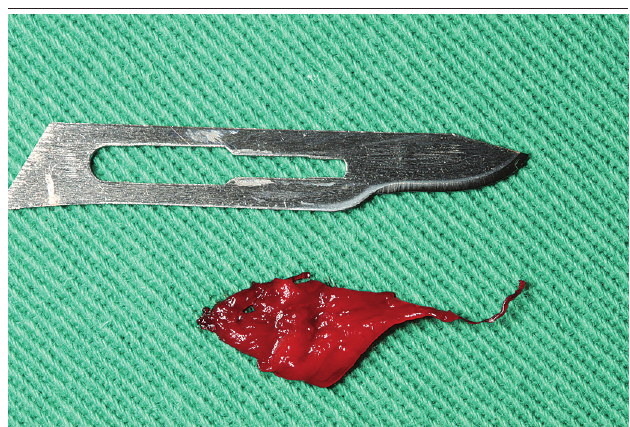
figurE 6 − Specimen